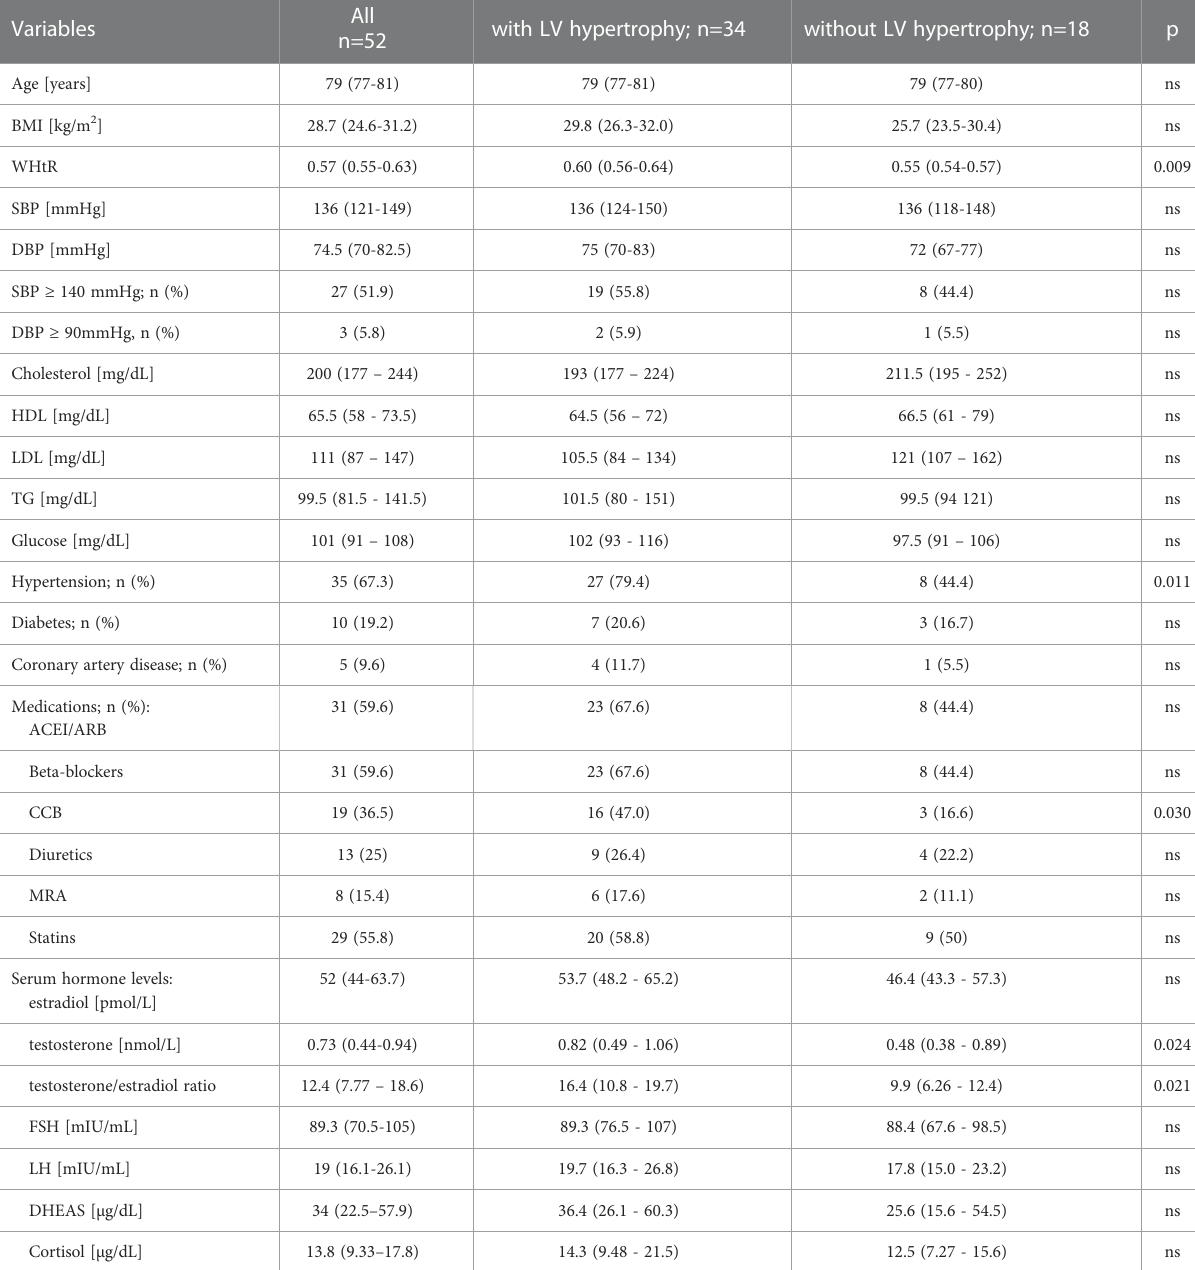
TABLE 1 Baseline characteristics of the study group and divided into a group with and without LV hypertrophy.